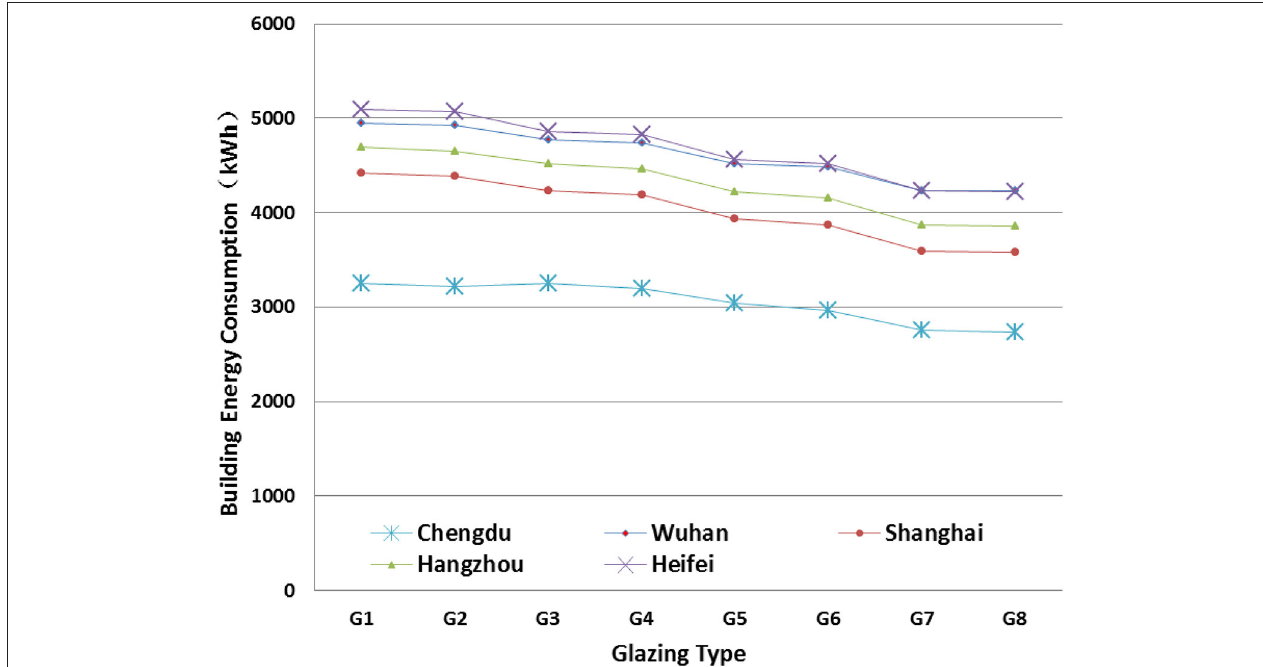
FIGURE 13 | Sensitivity analysis of glazing type on annual energy consumption.